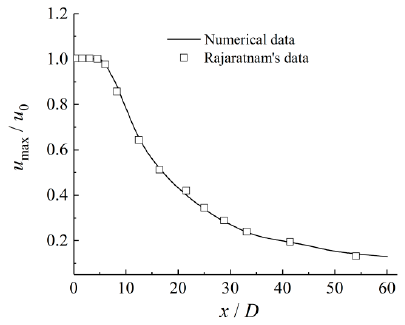
Figure 4. The decay of maximum velocity u max in the plane of symmetry of the wall jet.